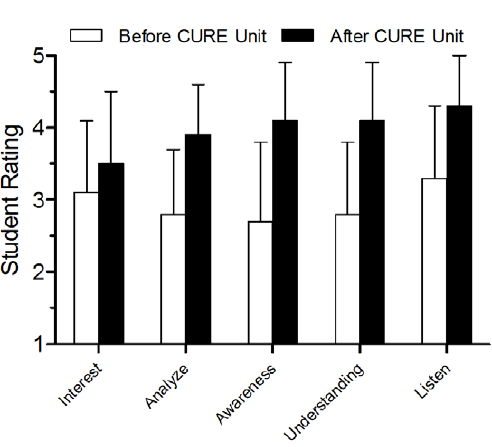
Ethics Unit. Mean scores for individual items of the retrospective items on the post-test for Cohort 1 students revealed significant gains (p , 0.001) in all self-reported items: Interest in science (N=308), ability to Analyze issues related to science and society and make well- justified decisions (N=306), Awareness of ethics and ethical issues (N=309), Understanding of the connection between science and society (N=308), and the ability to Listen and discuss different viewpoints (N=308). Lines represent standard deviations.